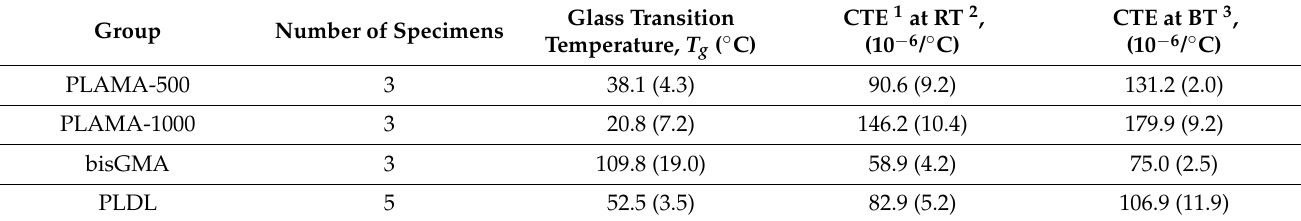
Table 5. Numerical results of the multicyclic thermomechanical analysis (TMA).